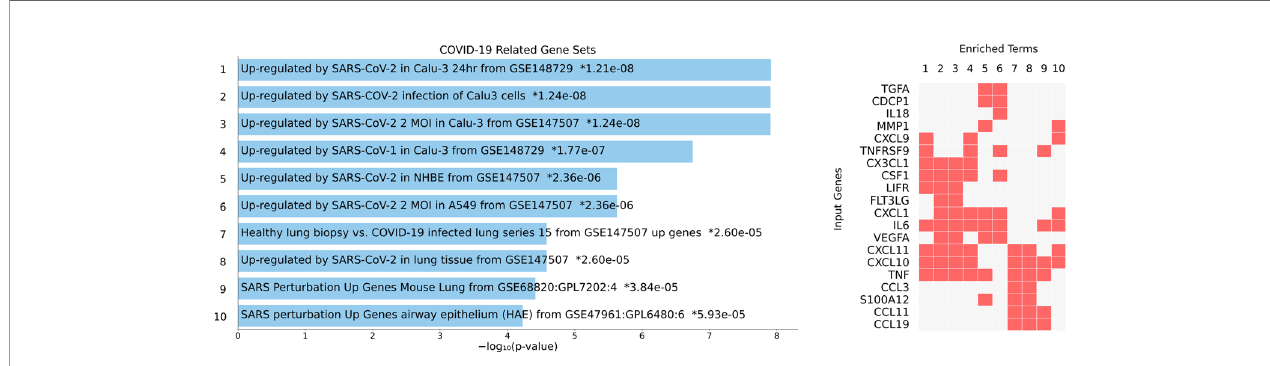
FIGURE 6 | Overlap between genes upregulated upon coronavirus infection with the proteins detected in this study. The details on the experiment are indicated on the blue bars (left) with the P value for the enrichment analysis. Asterisks indicate signi fi cant enrichment after correction for multiple testing. The proteins detected in this study that coincide with the genes found in each experiment (1 to 10) are indicated by a red box